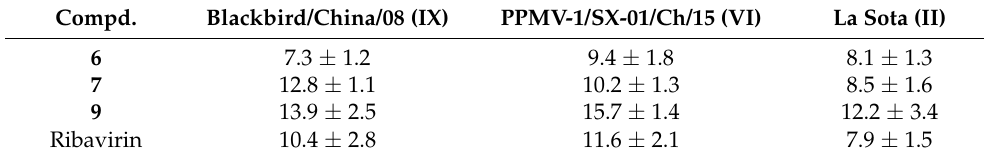
Table 4. IC 50 values ( µ M) of 1-formyl- β -carboline derivatives against three genotypes of NDV.